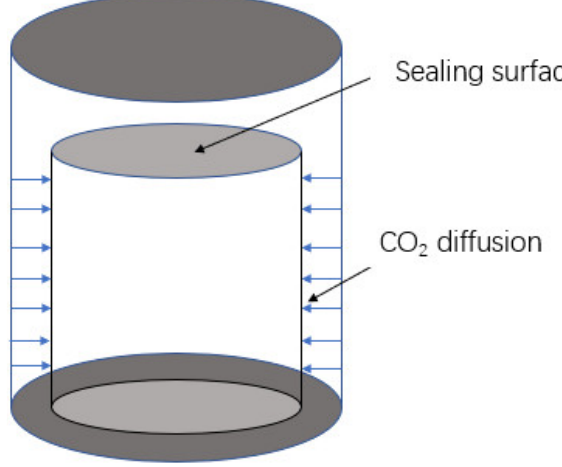
Figure 2. Schematic diagram of CO 2 diffusion physical model.